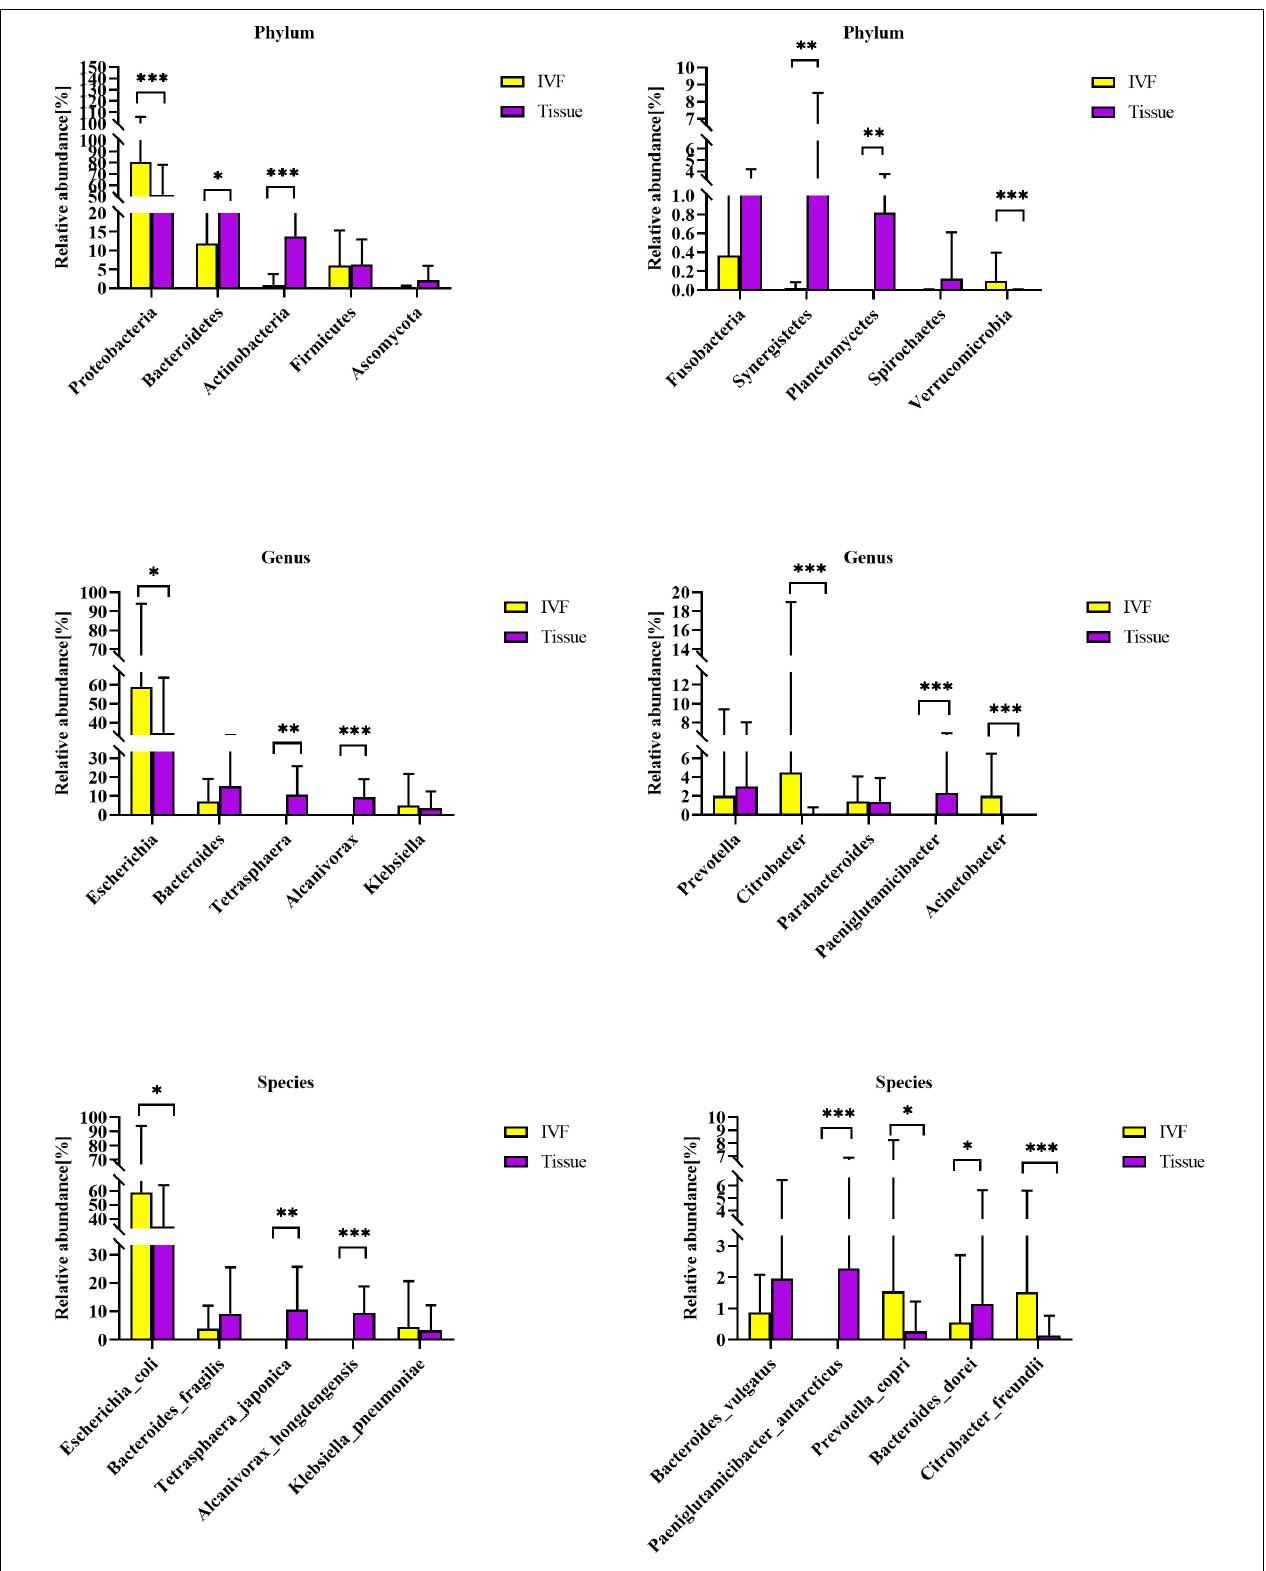
FIGURE 2 | Histogram of IVF and tissue at the phylum, genus, and species levels. IVF, intestinal lavage fluid; tissue, tumor tissue. ∗∗∗ p < 0.001, ∗∗ p < 0.01, ∗ p < 0.05.